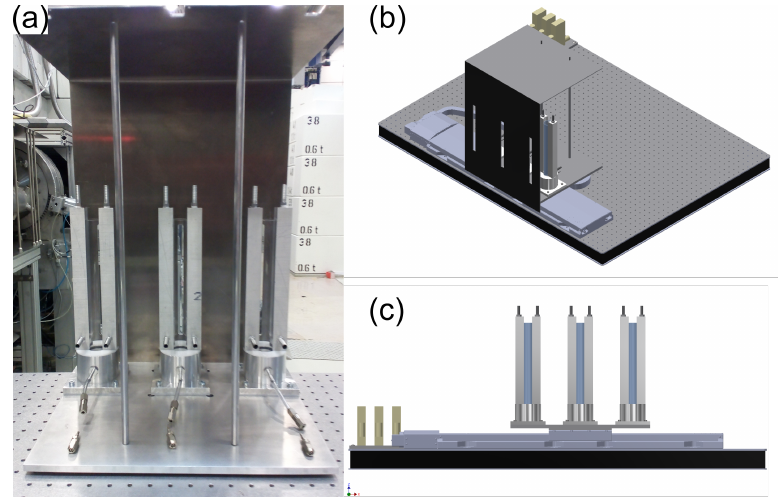
Figure 2. Overview of the sample environment (SE). ( a ) Backview of three foam cells on folded aluminum construction. ( b ) Technical drawing of the complete SE mounted on the breadboard. ( c ) Front view of the SE (technical drawing) without shielding.